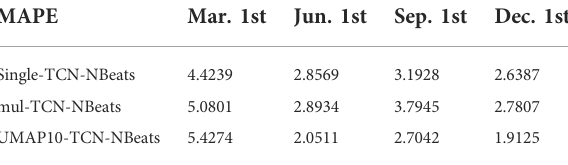
TABLE 3 Average MAPE under different models in different